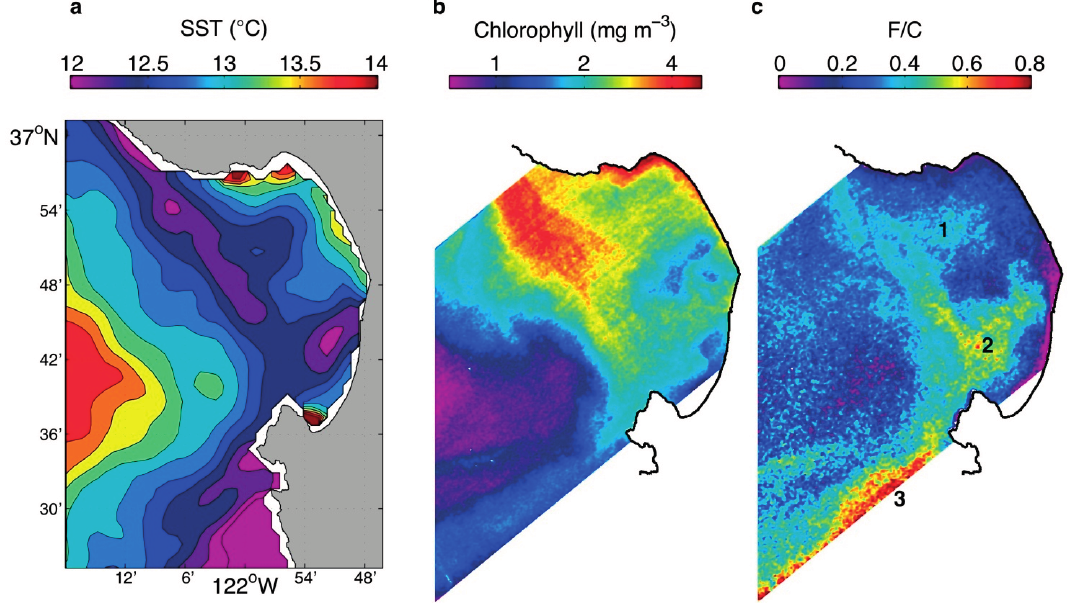
Figure 6. Spring 2011 study: Relationships between thermal signatures of upwelling nutrient supply ( a ) and bio-optical characterization of phytoplankton ( b , c ). F/C